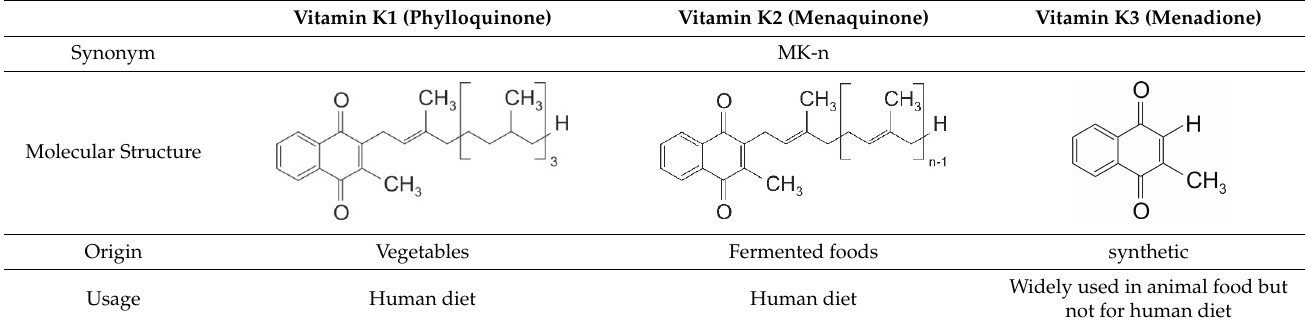
Table 1. Three forms of vitamin K.